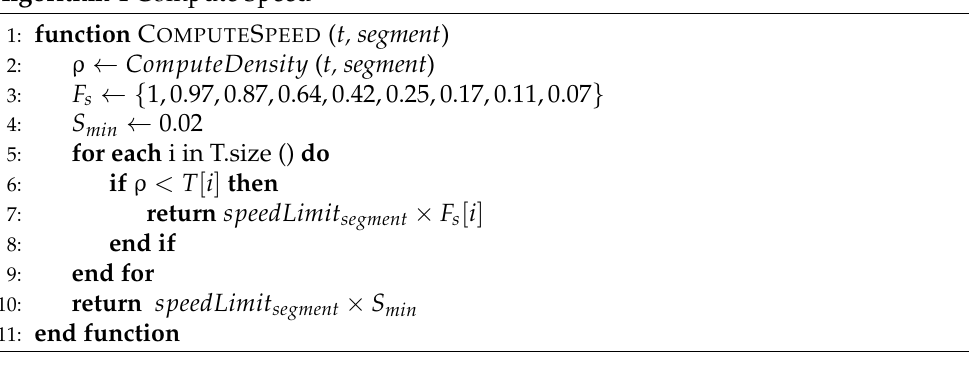
Algorithm 5 Compute